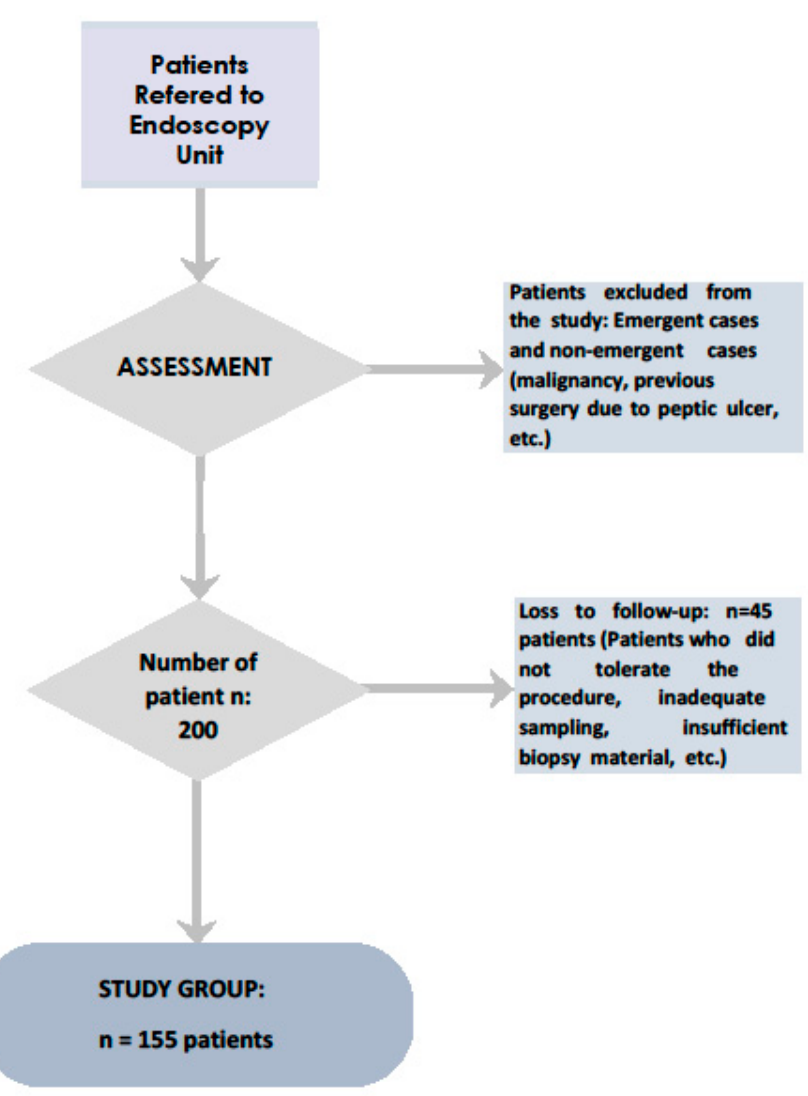
Figure 1. Flowchart of the selection of the study group patients.